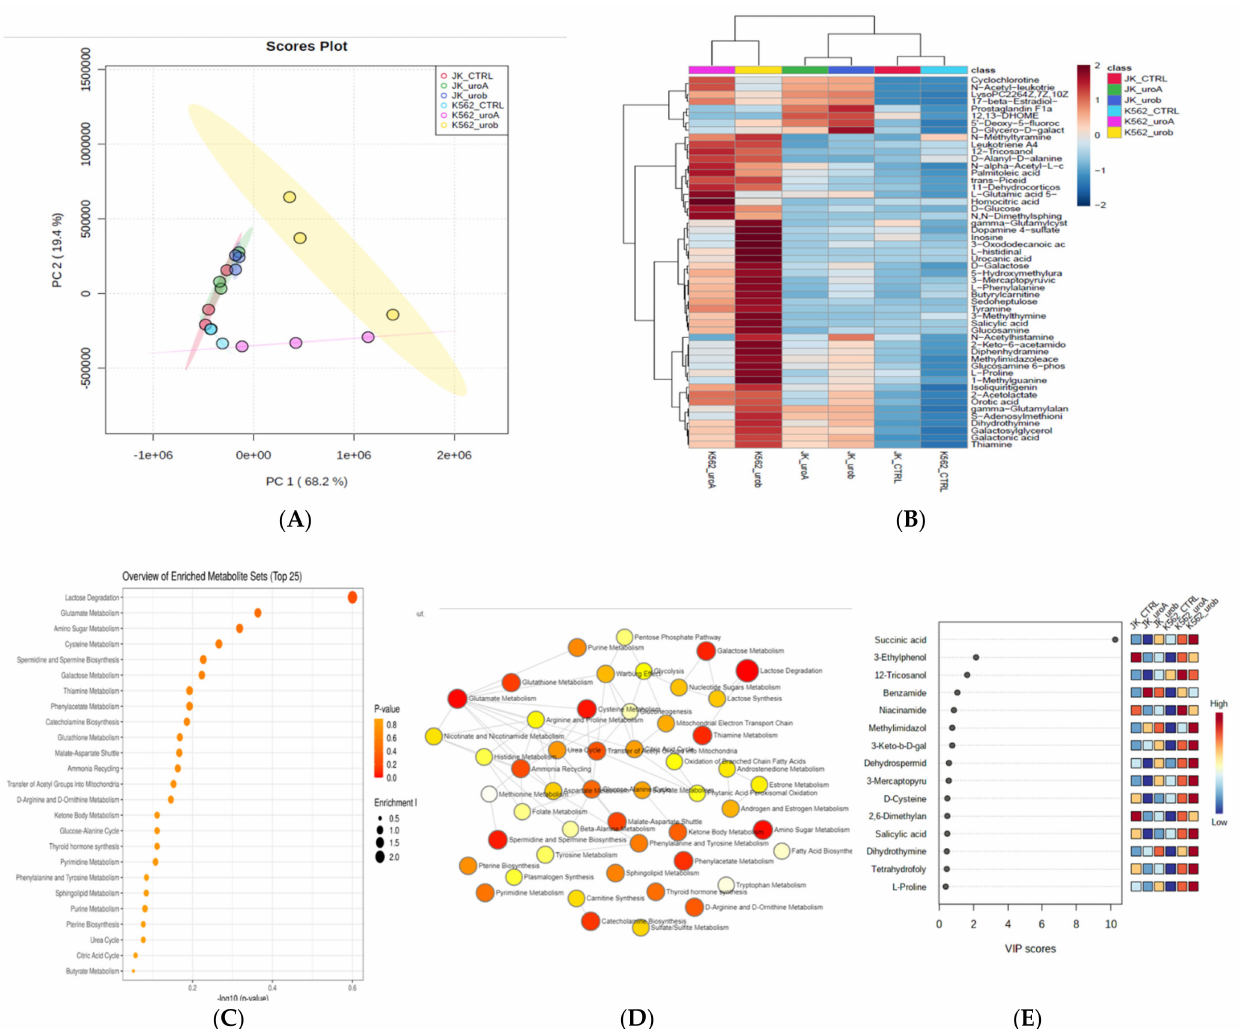
Figure 2. Metabolomic analysis of leukemic cells treated with urolithin A and B for 48 h: ( A ) PCA analysis of total metabolites of Jurkat and K562; ( B ) expression heat map of differential metabolites expressed in control and urolithin A- and urolithin B-treated cells; ( C ) top pathways enriched in Jurkat and K562 control and urolithin A- and urolithin B-treated cells; ( D ) pathway network analysis of Jurkat and K562 control and urolithin A- and urolithin B-treated cells; ( E ) VIP score for differentially expressed metabolites during urolithin A and B